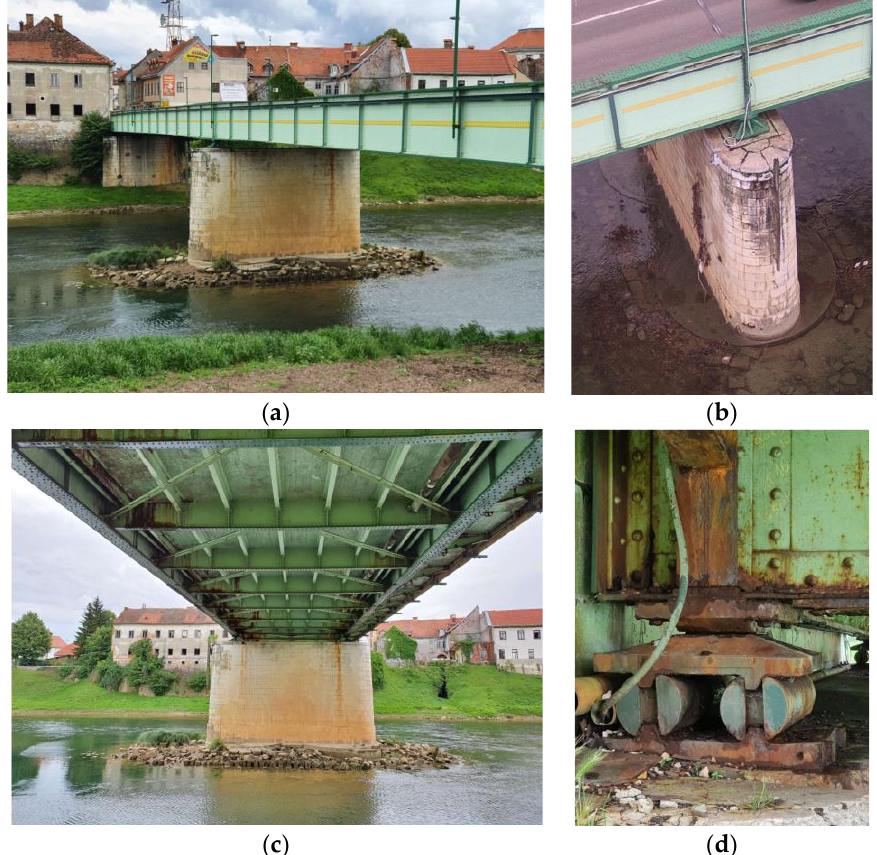
Figure 1. Overview of the case-study bridge: ( a ) side view, ( b ) detailed view of the middle pier and well foundations, ( c ) view below the bridge deck, and ( d ) detailed view of the roller bearing at the abutment.